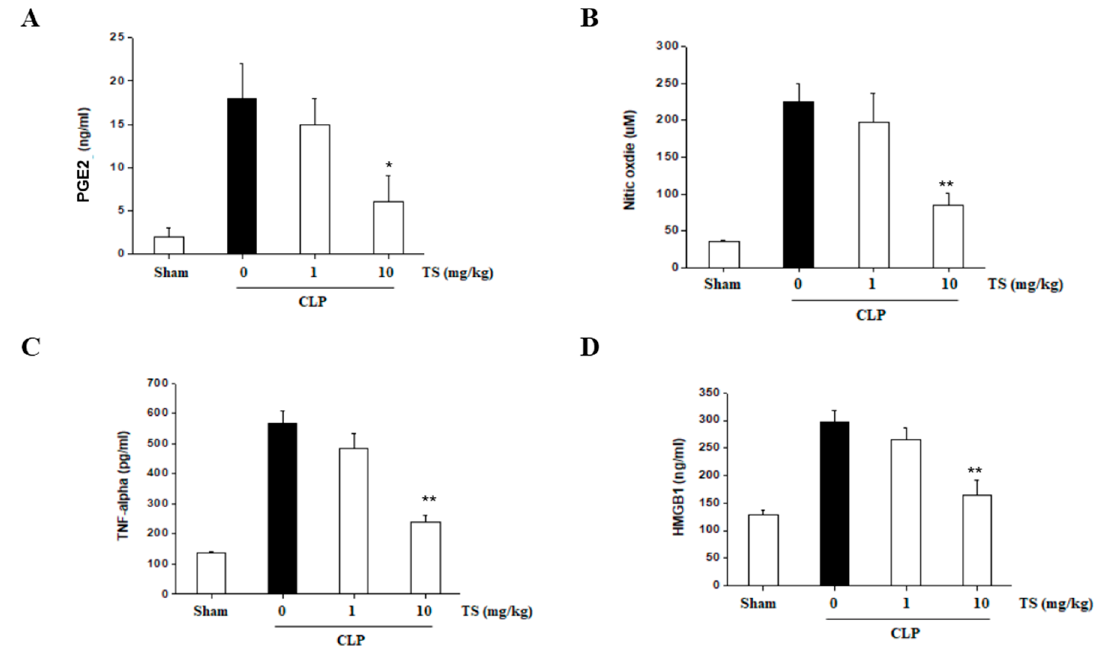
Figure 8. Effect of TS on the serum NO, PGE2, TNF- α and HMGB1 levels in CLP-induced septic mice. Serum concentrations of NO, PGE2, TNF- α and HMGB1 concentrations in each treatment group were measured by ELISA. Values are presented as means ± standard error (of the mean) ( n = 4–6 in each group). * p < 0.05, ** p < 0.01 vs. CLP-induced septic group. ( A ): PGE2; ( B ): NO; ( C ): TNF- α ; ( D ): HMGB1.